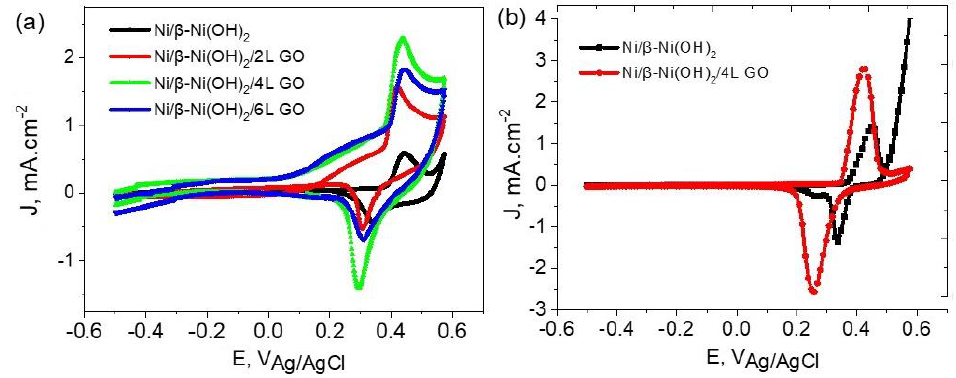
Figure 1. CVs for bare Ni/ β -Ni(OH) 2 and Ni/ β -Ni(OH) 2 coated with GO (2, 4, and 6 layers) for ( a ) 1st cycle and ( b ) 100th cycles in de - aerated 0.5 M KOH scan rate 50 mV s −1 .